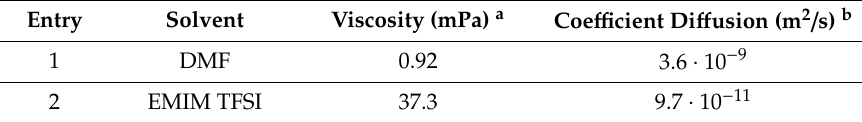
Table 3. Viscosities and coe ffi cient di ff usion values of DMF and EMIM